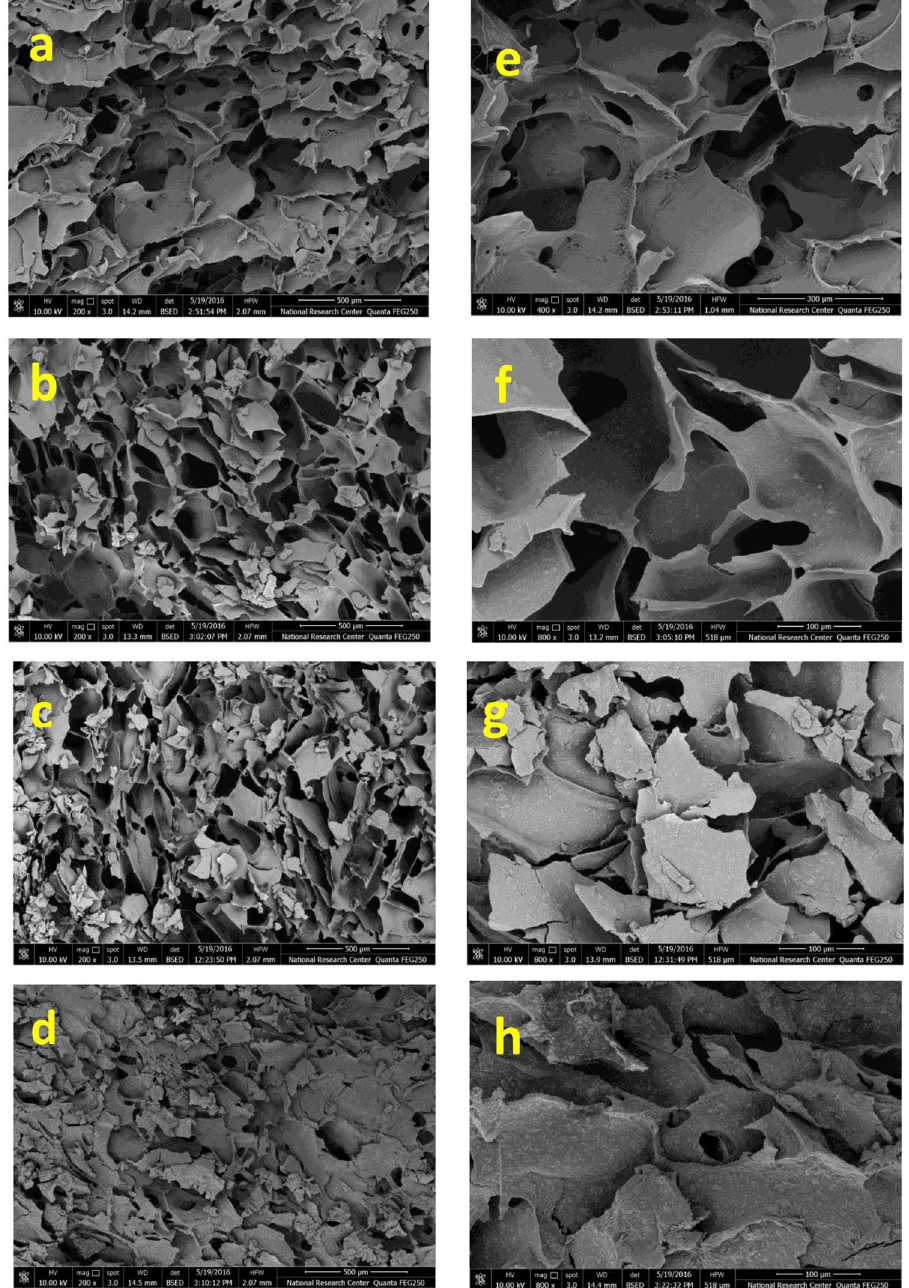
Figure 3. SEM micrographs of Dex-CS/nHA composite scaffolds with different nHA content at different magnifications ( a , e ) for 0 Wt%, ( b , f ) for 20 Wt%, ( c , g ) for 30 Wt% and ( d , h ) for 40